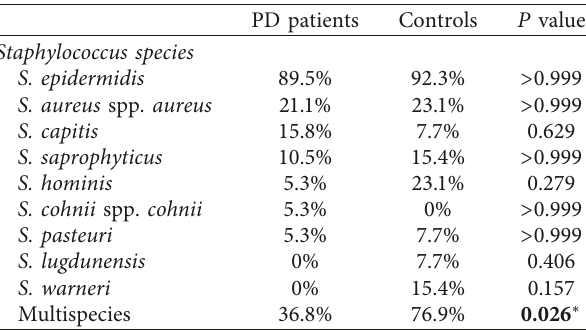
Table 4: Prevalence of Staphylococcus species identified in isolates from saliva of peritoneal dialysis (PD) patients and